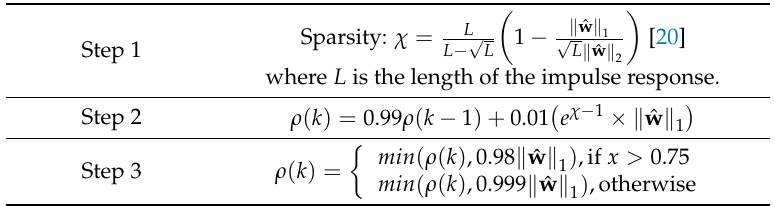
Table 1. ρ selection method in the sparsity regularization constant γ k . Step 1